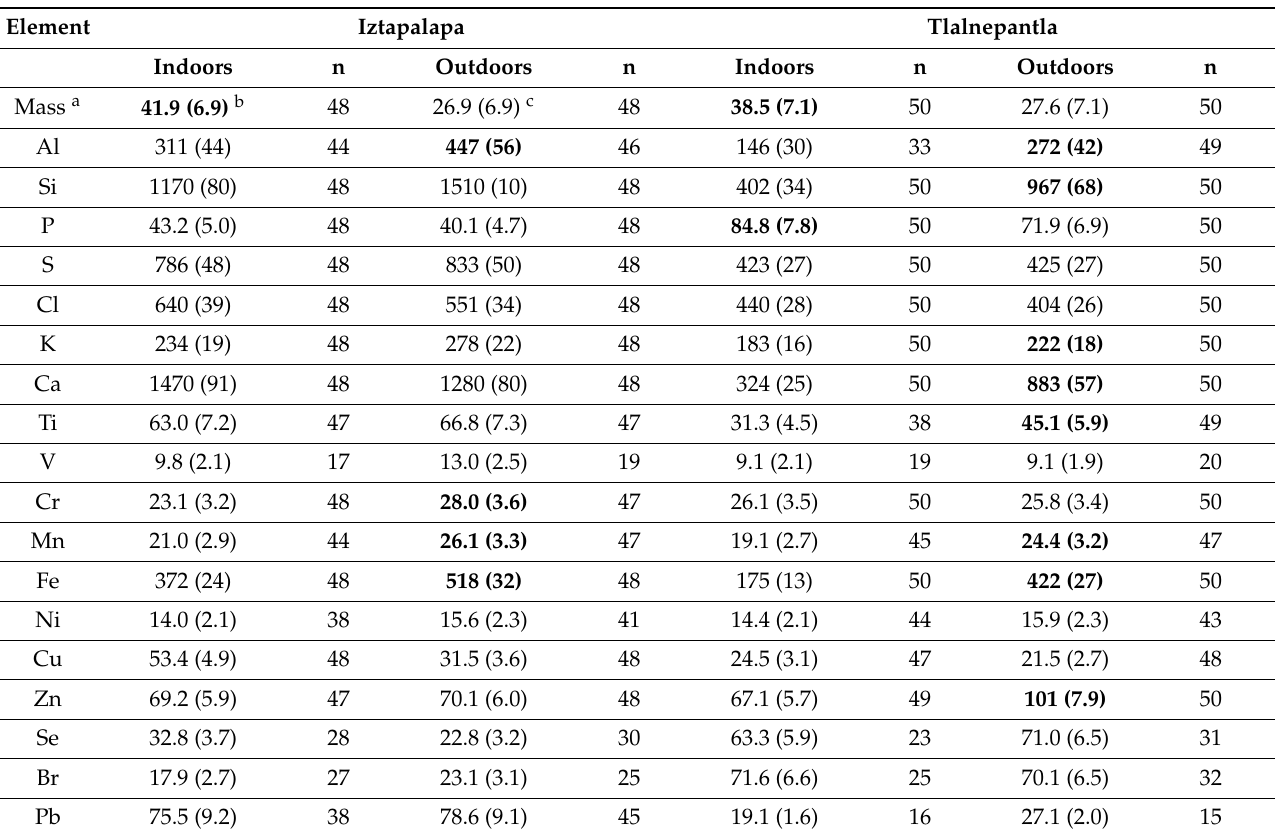
Mean gravimetric mass and elemental concentrations (ng m − 3 ) measured in the sampling